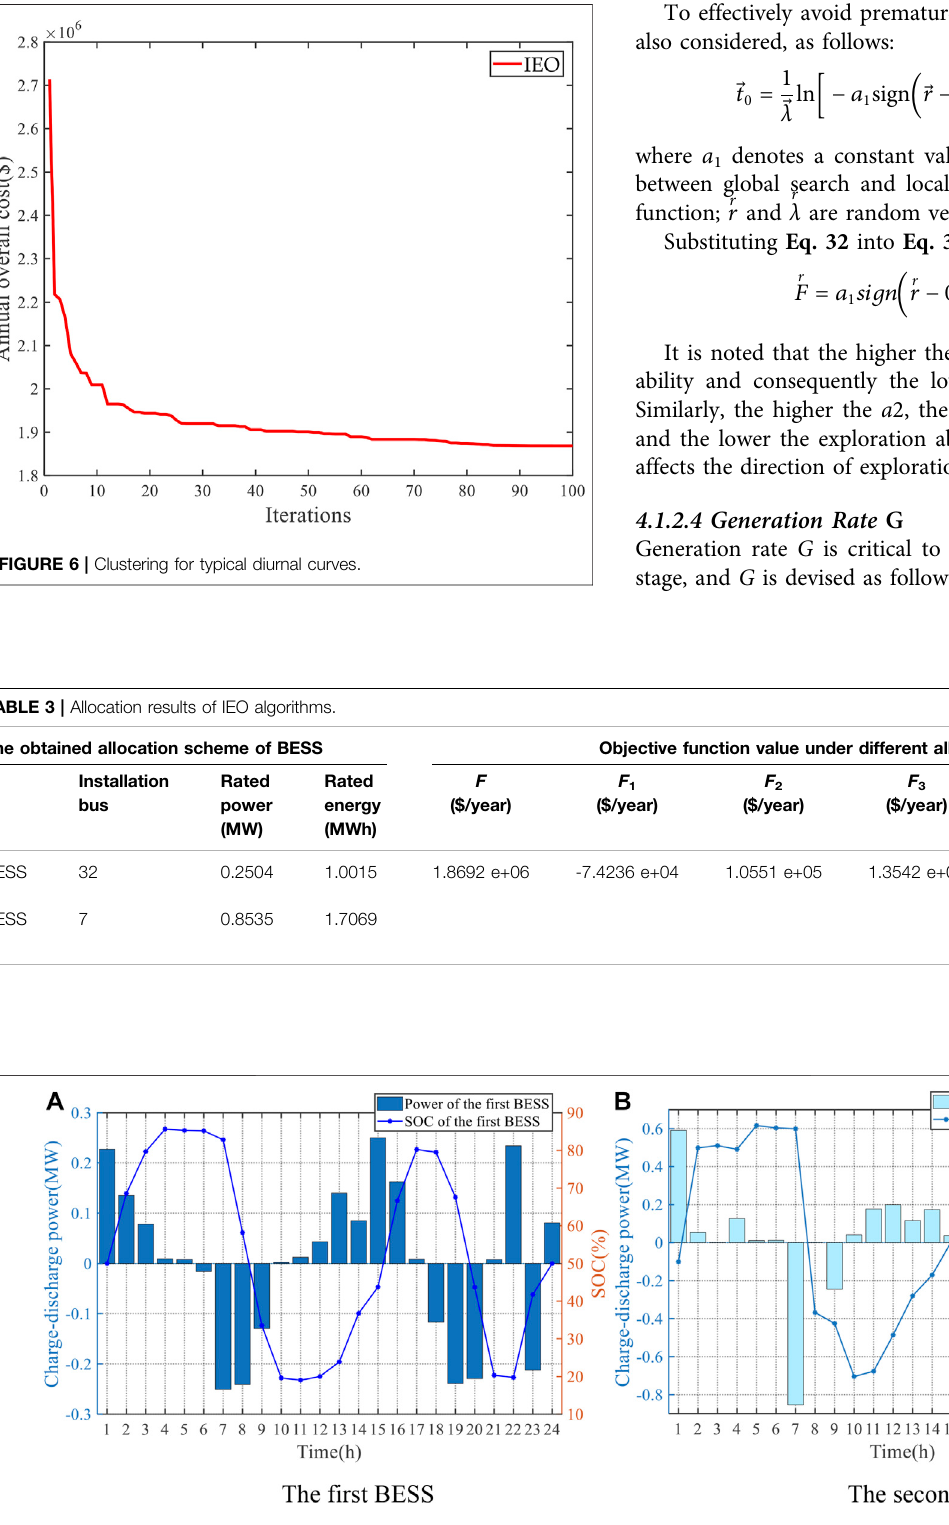
FIGURE 7 | Real-time operation conditions of two BESSs. (A) First BESS and (B) second BESS